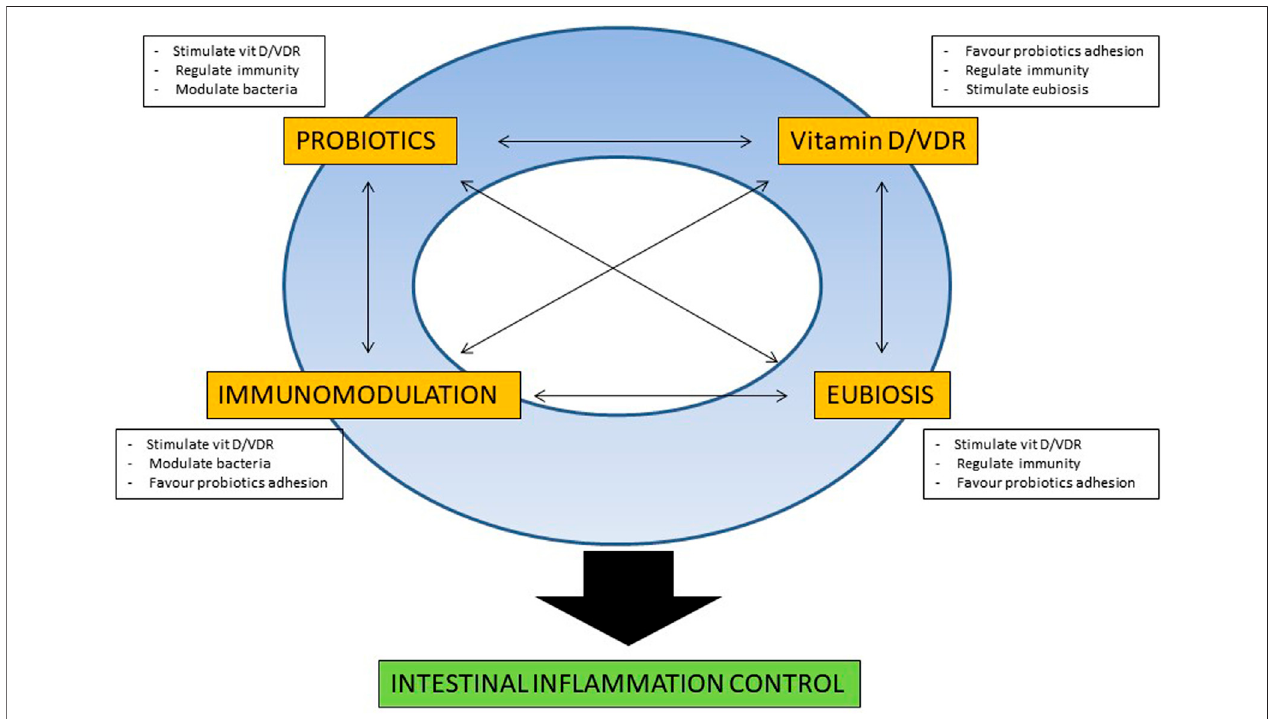
FIGURE1| Schematic representation ofthepossible reciprocal molecular interactions between probiotics and vitamin D forintestinal mucosal homeostasis.Fora detailed explanation refer to the text.